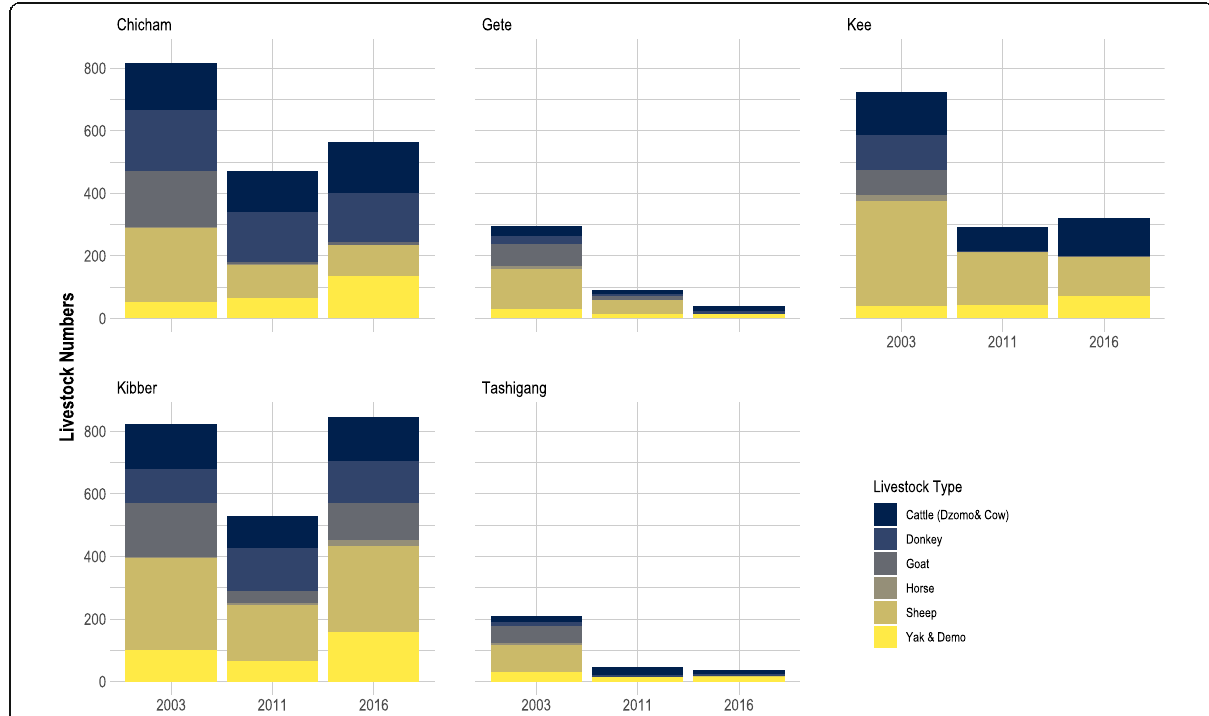
Fig. 3 Trends in the livestock numbers and composition between 2003 and 2016 indicating that livestock numbers have been dynamic in the region and have been an adaptation to the social and ecological changes at the local